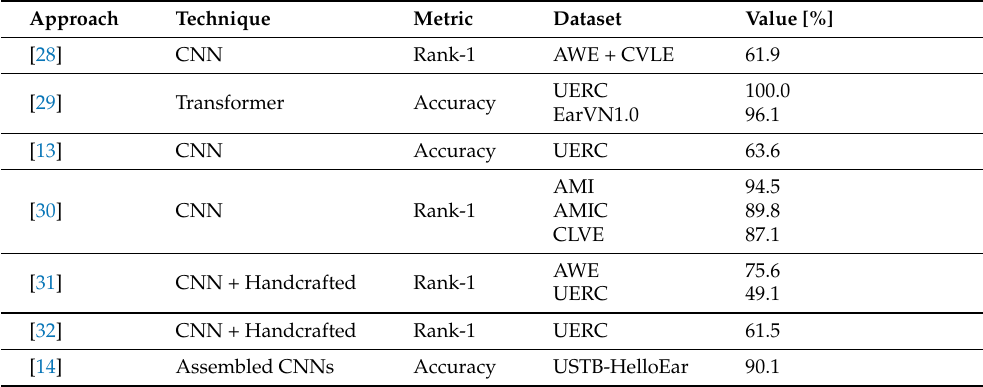
Table 2. Summary of the latest ear recognition